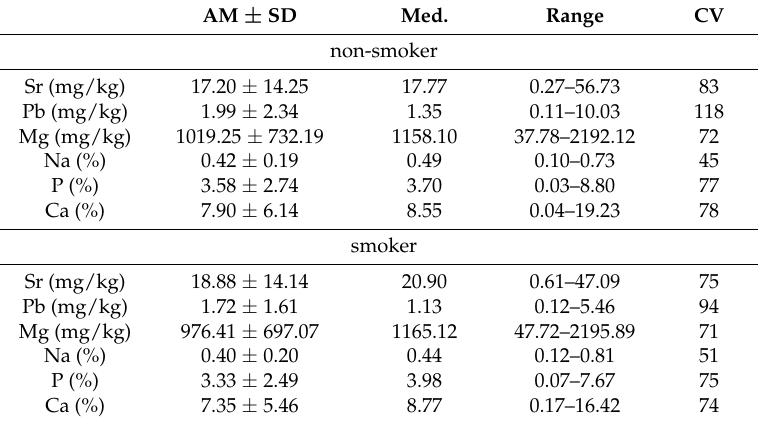
Table 3. Statistical characteristics for concentration of strontium, lead, magnesium, sodium, phosphorus and calcium in tissues of the knee joint people non-smoker and smoker (AM—arithmetic mean; SD—standard deviation; Med—median; CV—coefficient